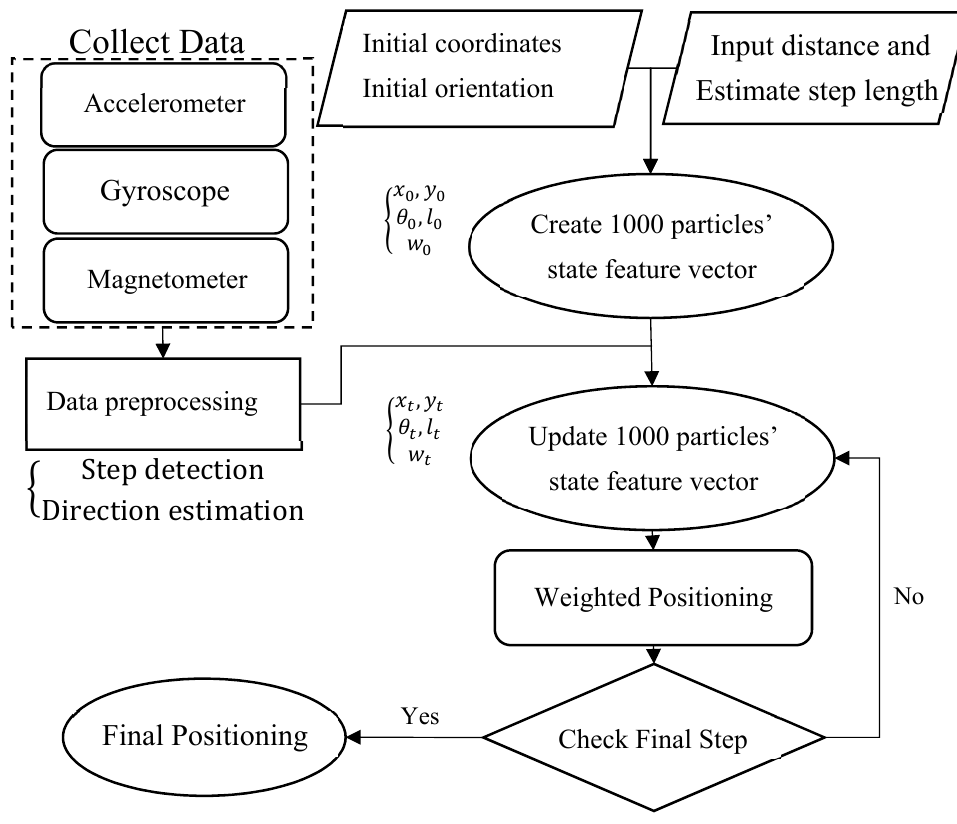
Figure 10. Positioning process involving the particle filter method and PDR.